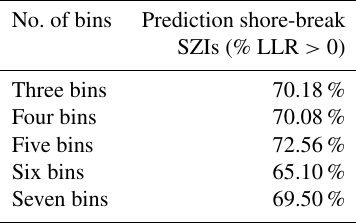
Table 5. The percentage of LLR > 0 for shore-break SZIs, indi- cating whether the prediction of the model is better than the prior